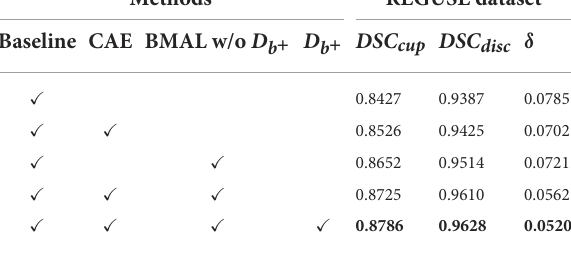
TABLE 5 Ablation experiments on the REFUGE test set. Methods